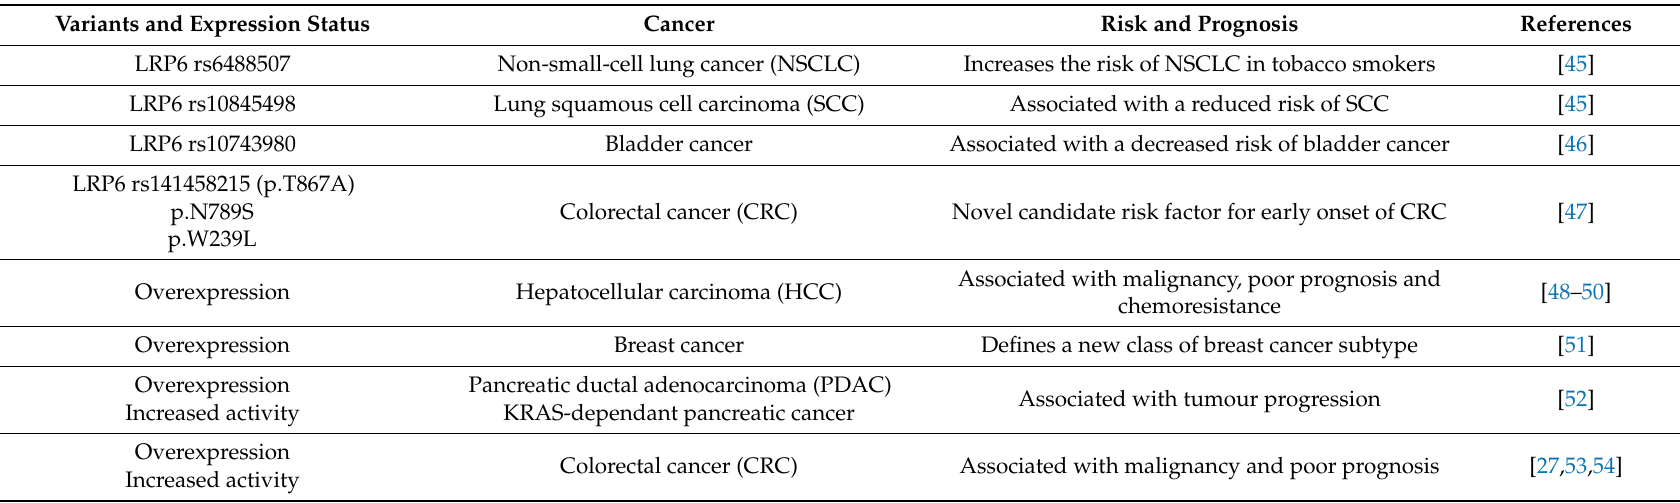
Table 1. LRP6 functional variants and expression status in distinct cancers. Some single-nucleotide polymorphisms (SNPs) and mutations in the LRP6 gene have been associated with increased or decreased risk of cancer